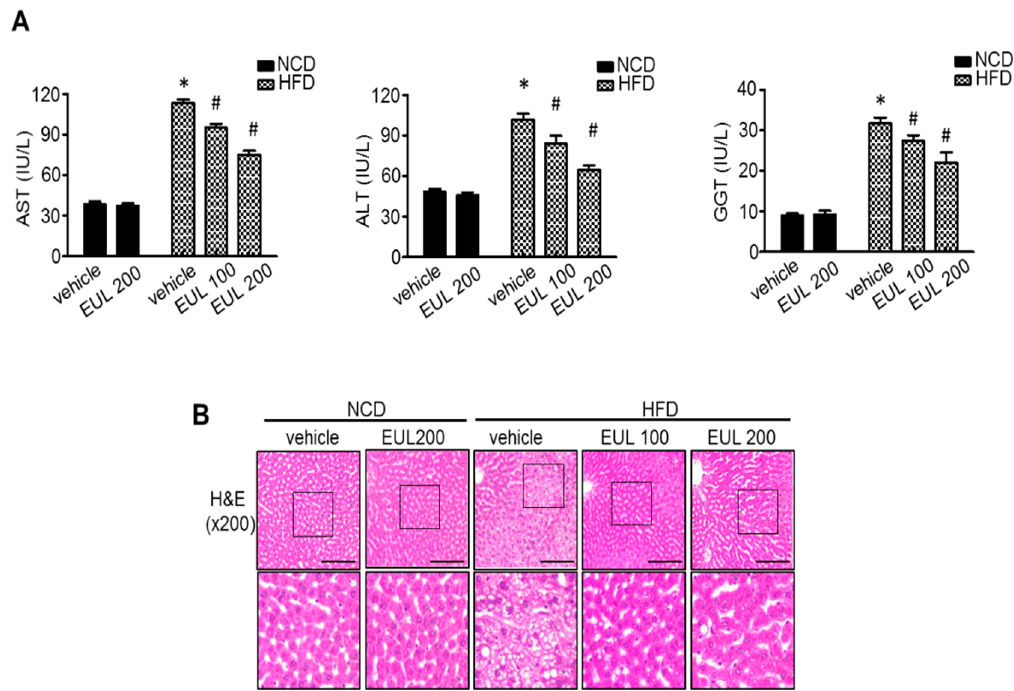
Figure 1. EUL ameliorates HFD-induced hepatic stress. Rats were fed a NCD or a HFD with or without administration of 100 mg/kg or 200 mg/kg EUL for 6 weeks, and sera and livers were harvested. ( A ) Biochemical analyses of serum samples. Serum levels of AST, ALT, and GGT in the different experimental groups. ( B ) Liver tissues retrieved 6 weeks after initial EUL administration and were subjected to H&E staining. Scale bars, 200 µm. Values are means ± SDs. ( n = 6, * p < 0.05 versus NCD group, # p < 0.05 versus HFD group). NCD, normal chow diet; HFD, high-fat diet; EUL, Eucommia ulmoides leaf extract; AST, aspartate aminotransferase; ALT, alanine aminotransferase. GGT, gamma- glutamyltransferase.